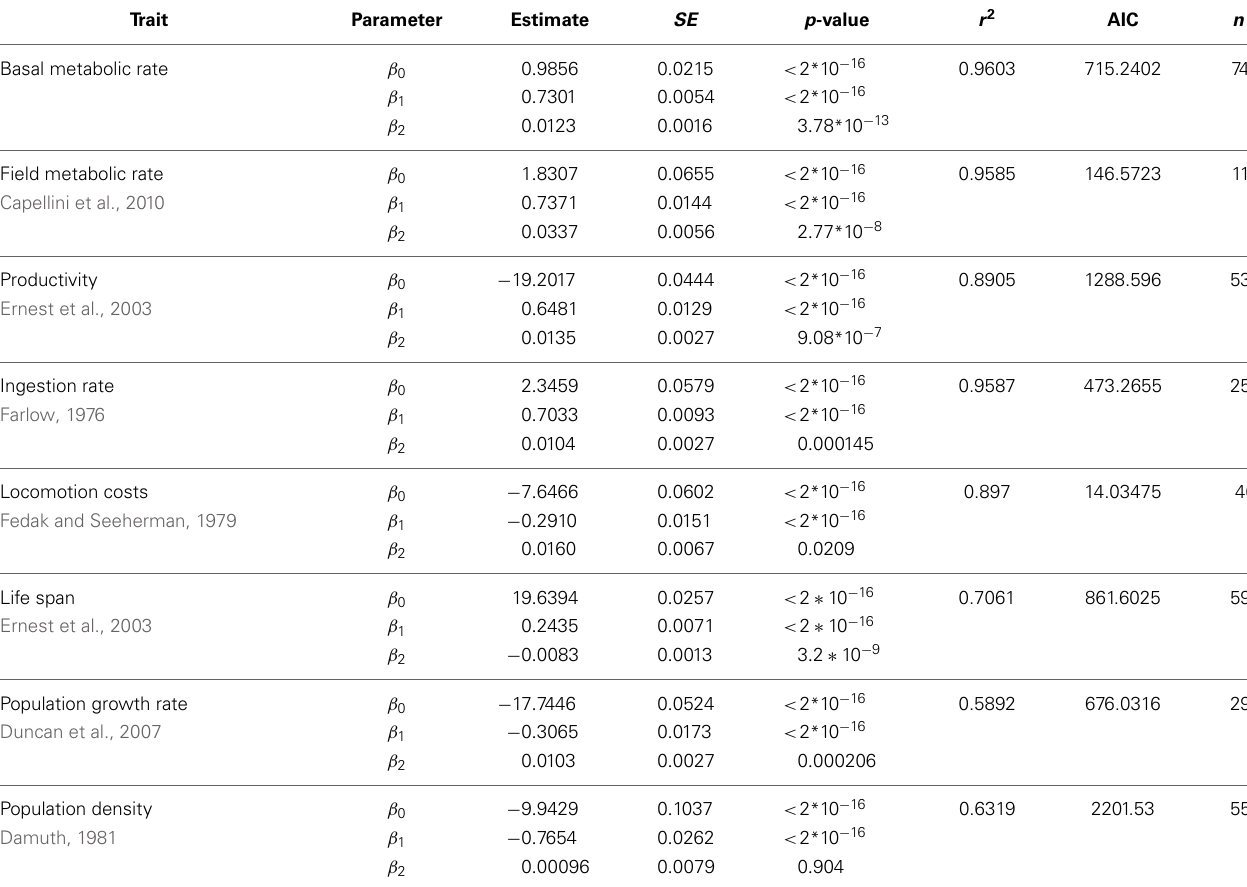
Table 3 | Fit of the data in Figure 1 of the main text using a quadratic model ( ln ( Trait ) ∼ β 0 + β 1 ln ( M ) + β 2 ( ln ( M )) 2 ).